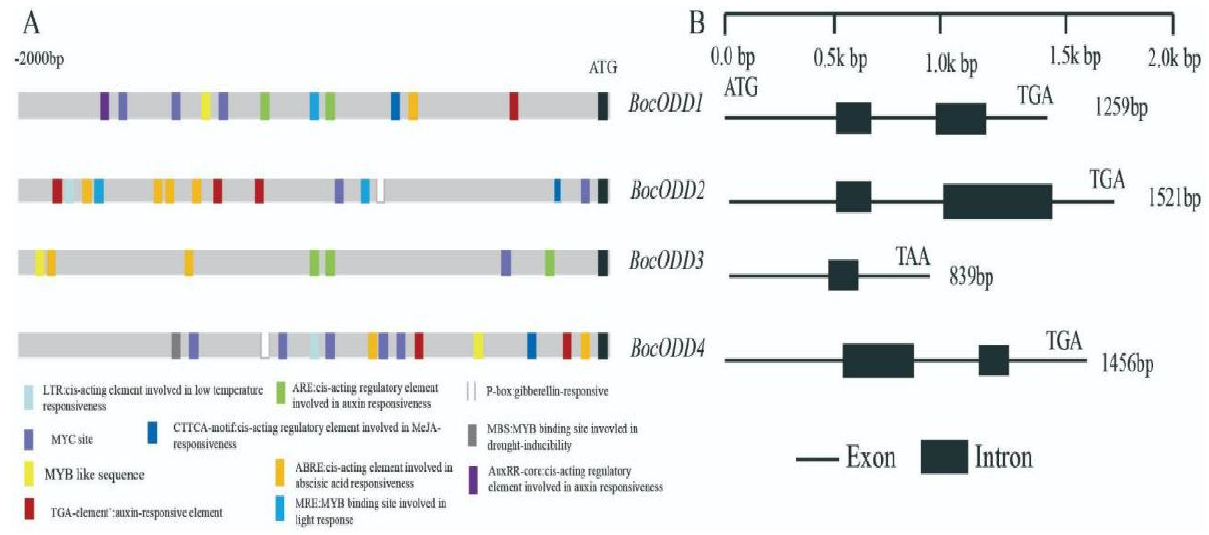
Figure 3. The structure of four ODD genes and their promoters in Chinese kale. ( A ) The structure of promoters; ( B ) the structure of DNA sequence. promoters; ( B ) the structure of DNA